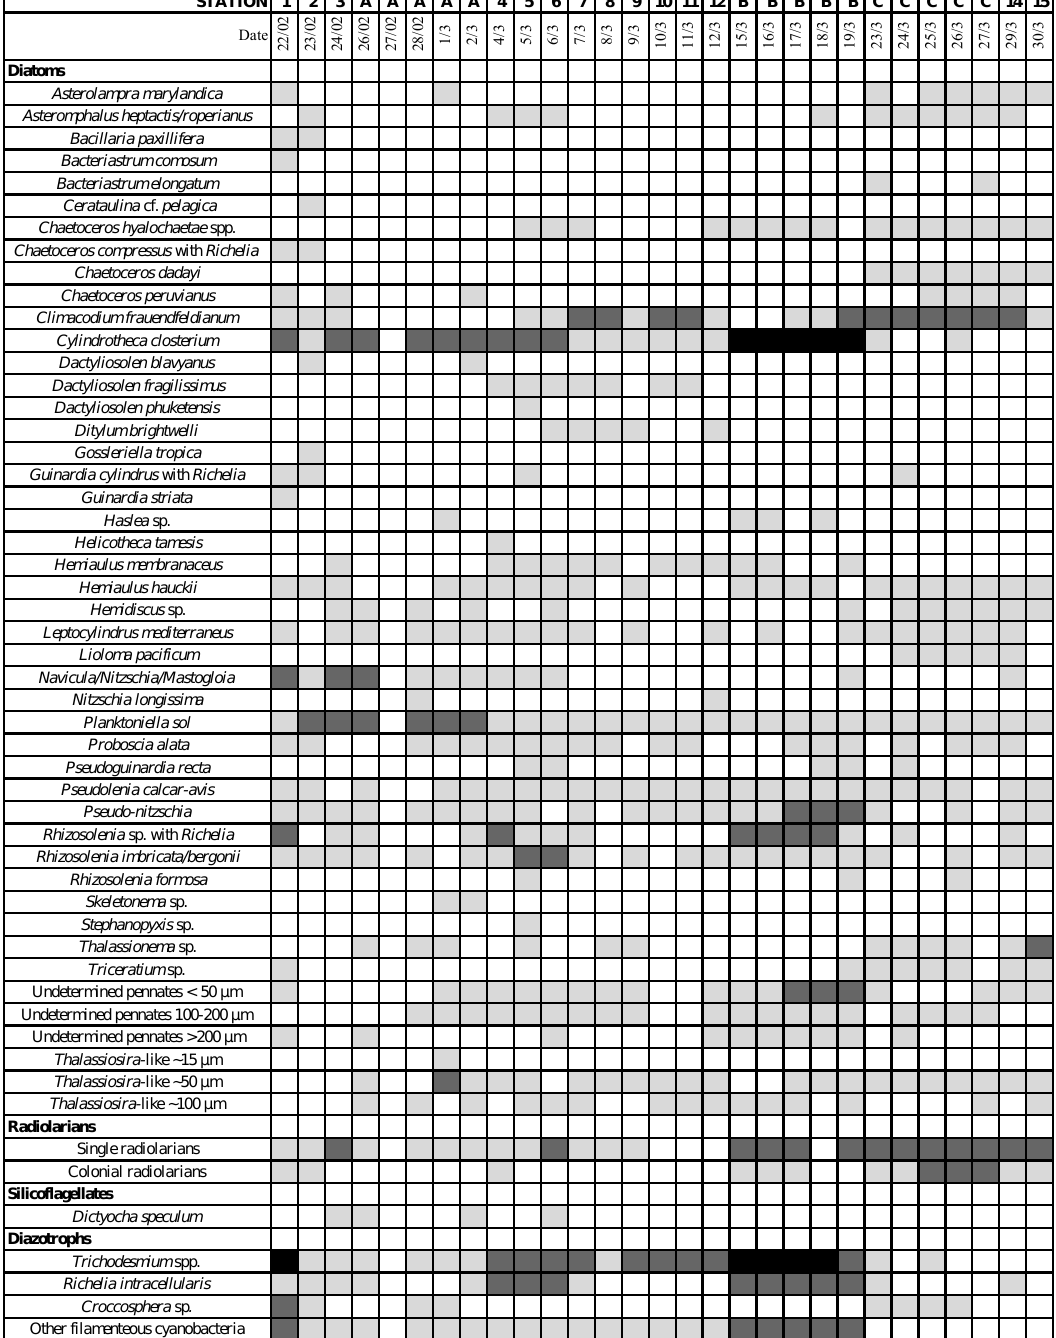
Table C1. Semiquantitative contribution of siliceous plankton (diatoms, radiolarians, silicoflagellates) and diazotrophs in plankton nets hauls of 35µm mesh size (over 0–150m at all sites except but over 0–200m at stations 14 and 15) during the OUTPACE cruise. Long- duration stations were sampled every day. Light gray, medium gray and dark gray correspond to minor, common and dominant abundances